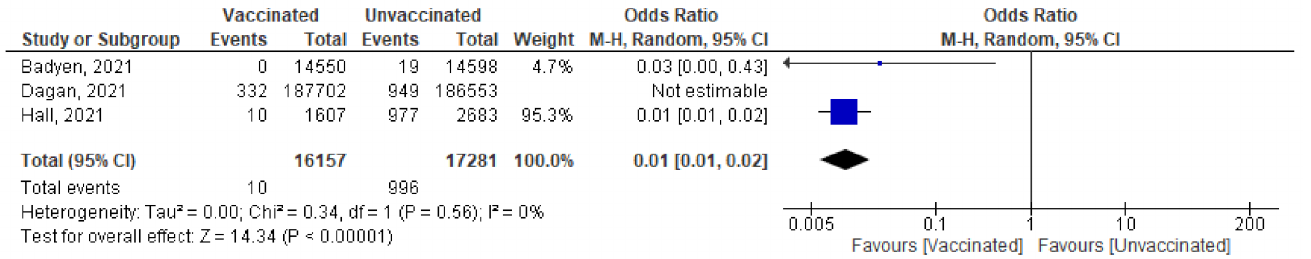
Figure 10. Incidence of SARS-CoV-2 infection either symptomatic or asymptomatic within 14 days of 2nd dose of